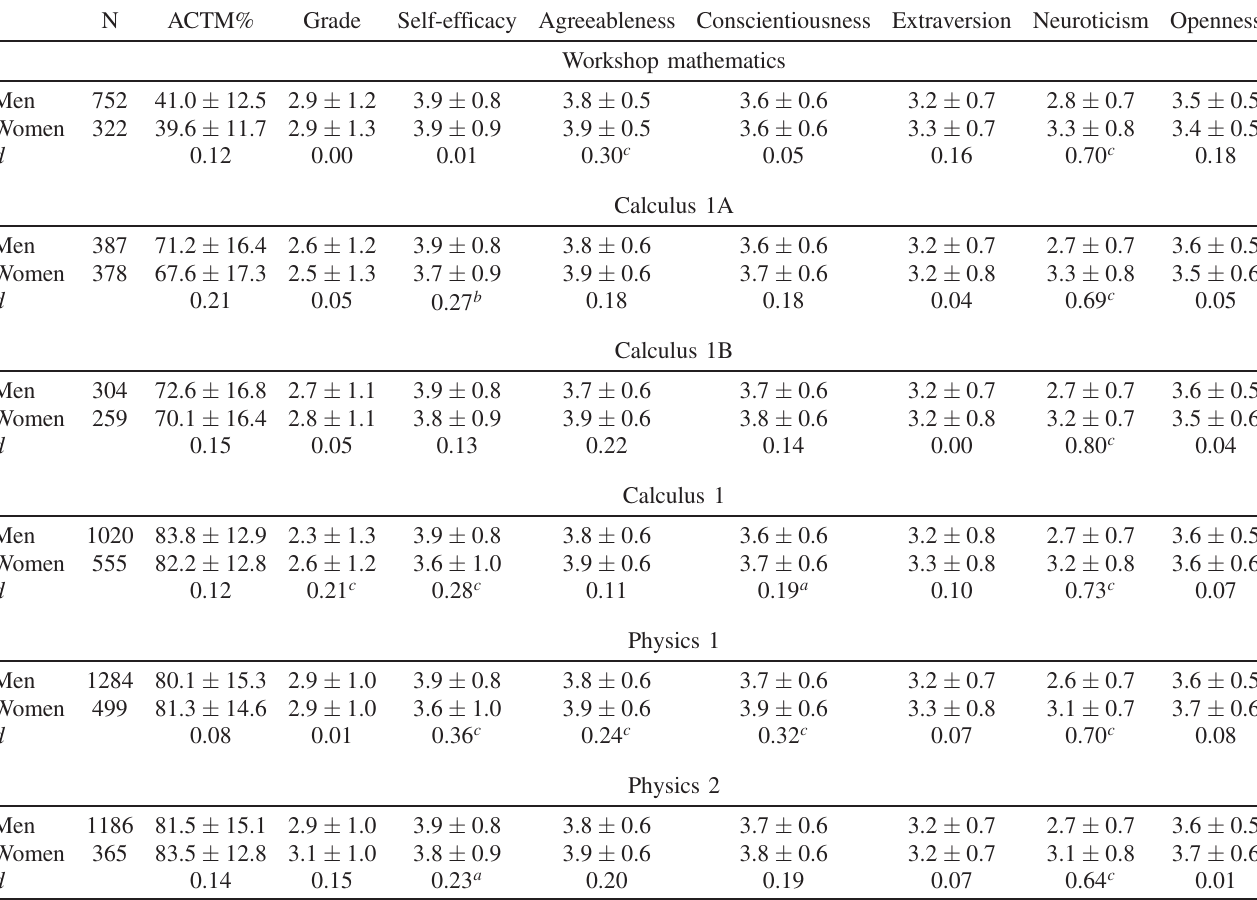
TABLE I. Descriptive statistics. Cohen ’ s d measures the effect size for the difference between men and women for each quantity. The significance of a t -test of the difference between men and women is shown as a superscript on d . Note: “ a ” denotes p < 0 . 05 , “ b ” p < 0 . 01 , and “ c ” p < 0 . 001 . A Bonferroni correction was applied to the significance